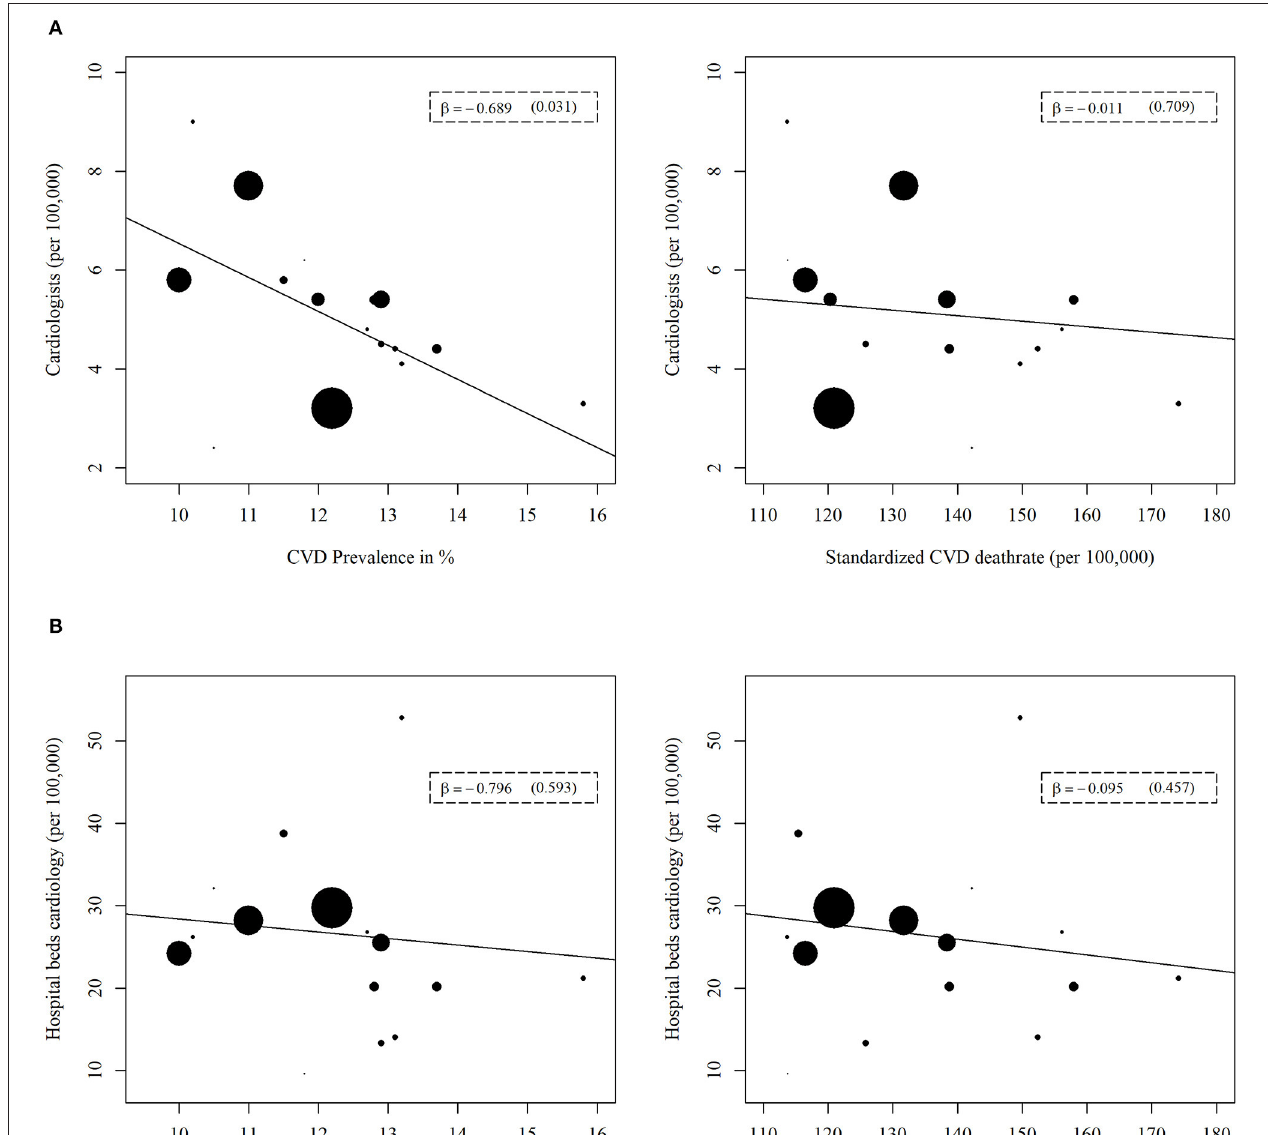
FIGURE 3 | Regression analyses of cardiological health care supply indicators with prevalence or mortality of major cardiovascular disease (CVD). The cardiological health care supply indicators are (A) Number of cardiologists, (B) Number of hospital beds for cardiology. A weighted linear regression was done for every association. The weight refers to the population size of each federal state. The size of the data points reflects the different